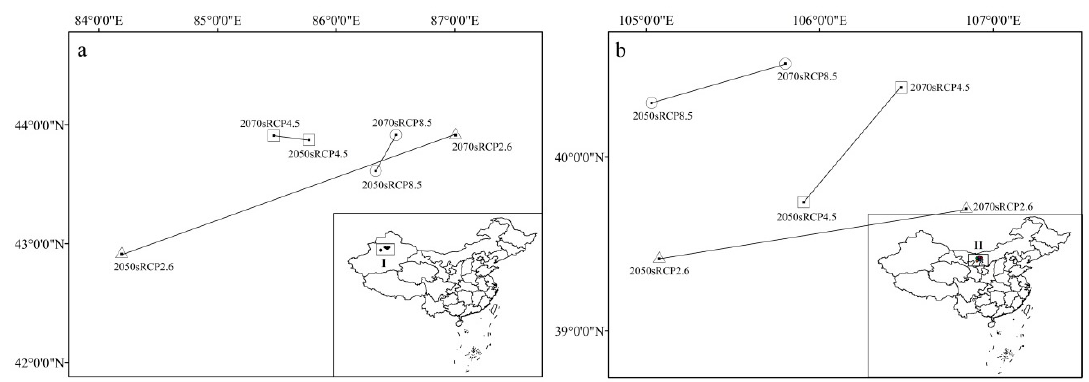
Figure 8. Migration pathway of C. deserticola under the RCPs from 2050s to 2070s in part I ( a ) and part II ( b ).